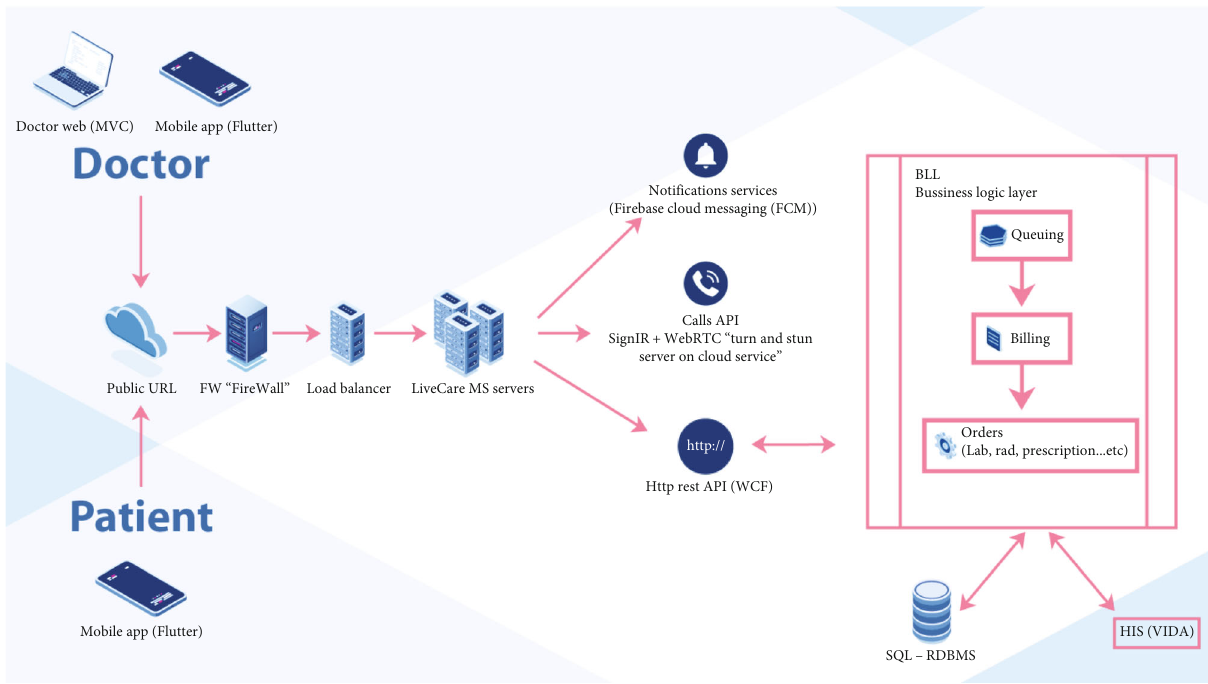
Figure 1: Hardware and software used to integrate live care to health information system. MVC =model view controller; URL =uniform source locator; MS =Microsoft servers; API =application program interface; HTTP =hypertext transfer protocol; SQL=structured query language; RDBMs=relational database management systems; HIS=health information system.